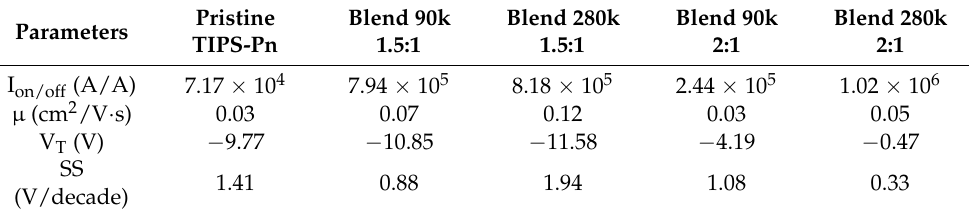
Table 1. Electrical properties of the TFTs fabricated with pristine TIPs-Pn, Blend 90k 1.5:1, Blend 280k 1.5:1, Blend 90k 2:1, and Blend 280k 2:1 extracted from the transfer characteristics under dark conditions.